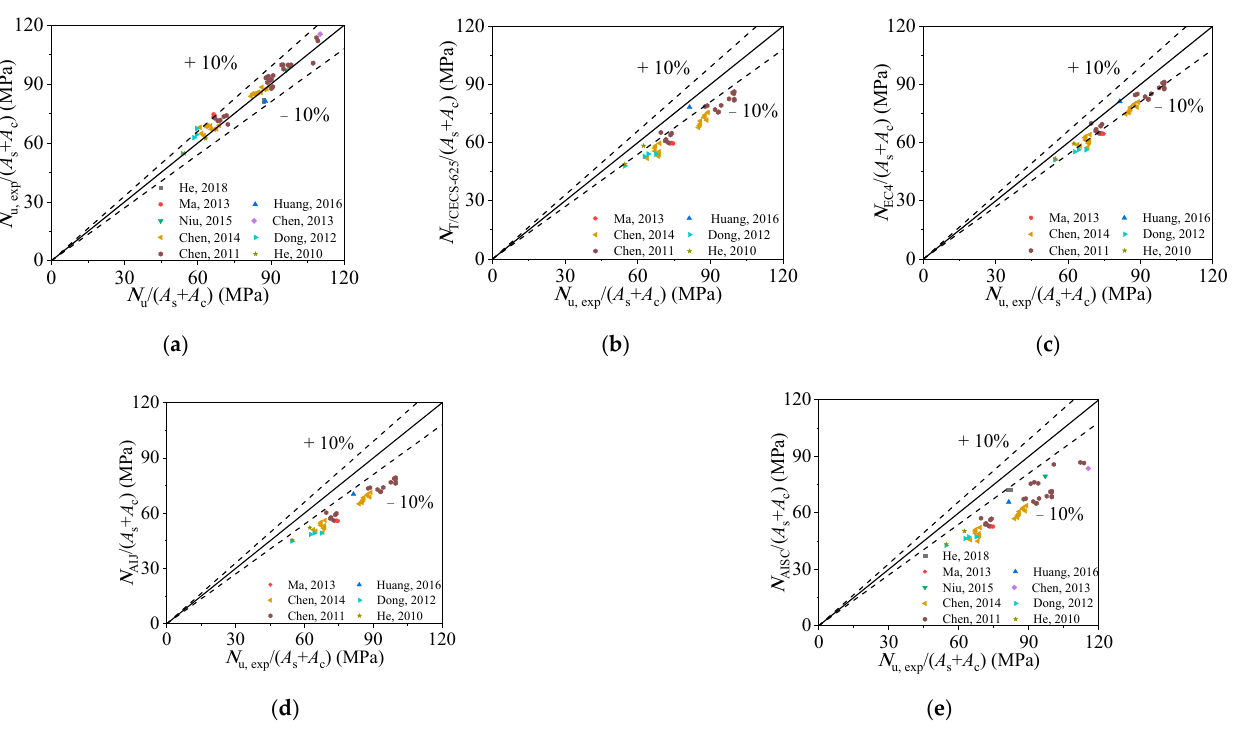
Figure 14. Comparison of experimental results and design methods’ results: ( a ) comparison of ultimate bearing stress obtained from test results and ACI-318-11 [50]; ( b ) comparison of ultimate bearing stress obtained from test results and T/CECS 625-2019 [51]; ( c ) comparison of ultimate bearing stress obtained from test results and EC4 [52]; ( d ) comparison of ultimate bearing stress obtained from test results and AIJ [53]; ( e ) comparison of ultimate bearing stress obtained from test results and AISC 360-16 [54]. Table 5. Summary of available formulae in well-known international